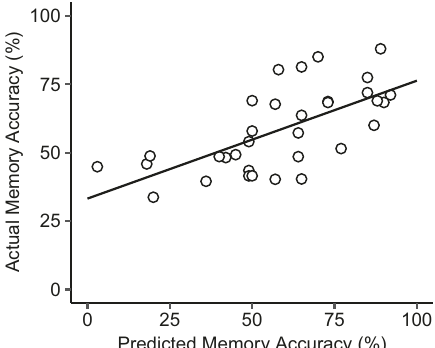
Fig. 3 Scatter plot and regression line of the actual by predicted values of multiple regression analysis on memory accuracy performance in patients with schizophrenia. Available data was available for n = 35 patients (85.4% of the total patient